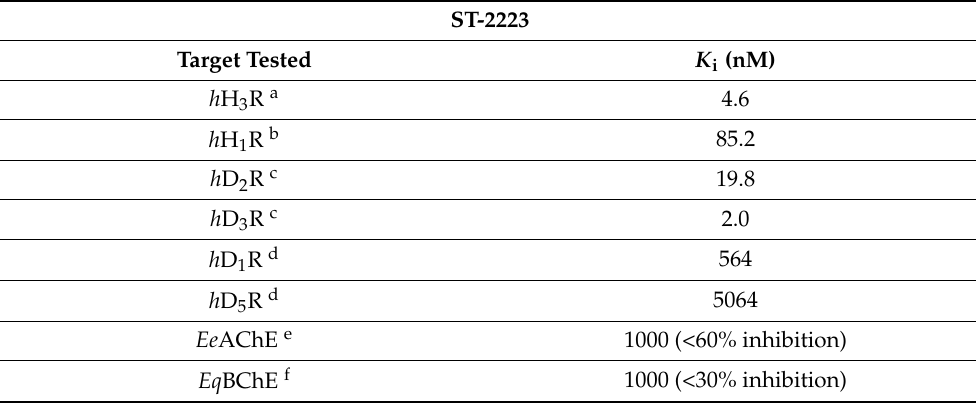
Table 1. In vitro affinities of the multi-active ligand ST-2223 at different histamine and dopamine receptor subtypes and